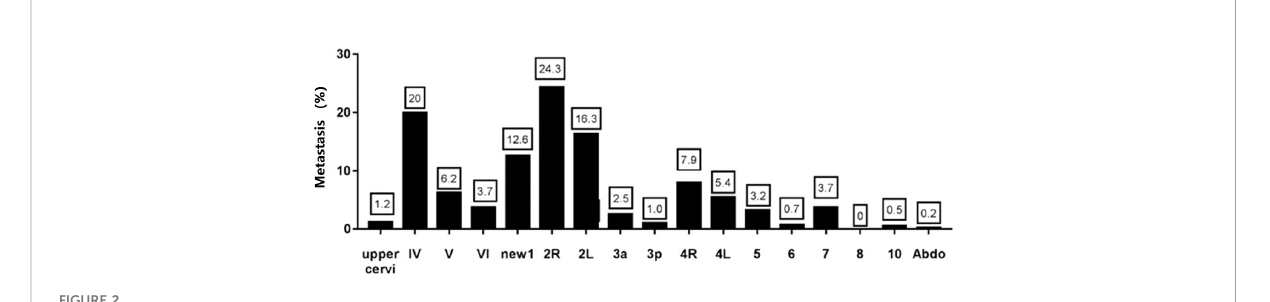
FIGURE 2 Metastasis rates by region in the initial lymph node metastasis pattern analysis.